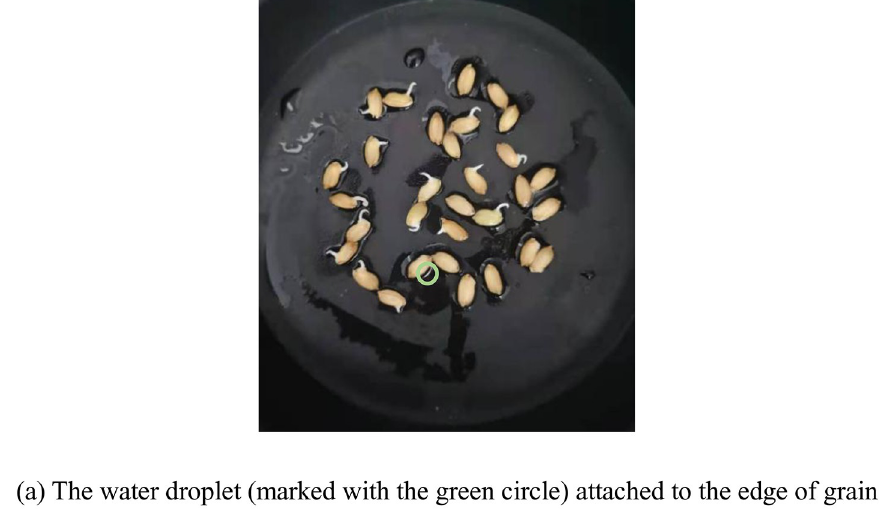
Fig 12. The results of the predicted and true values of germination rate for each image in rice varieties V1, V2, and V3: (a) V1, (b) V2, (c) V3.